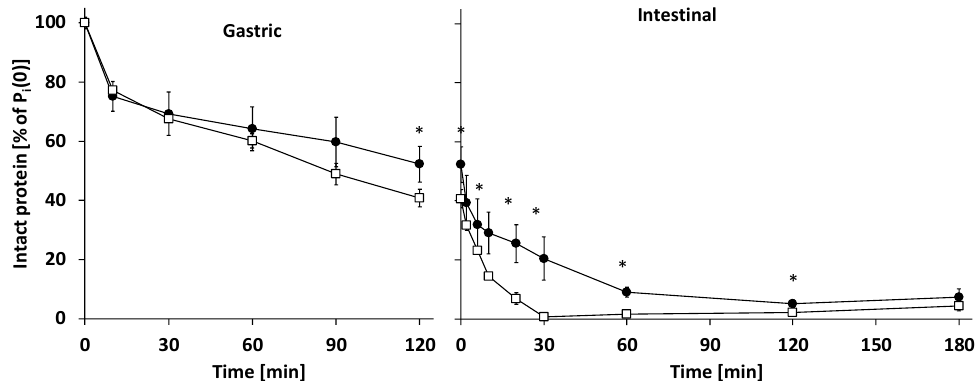
Figure 5. Total intact protein hydrolysis in gastric and intestinal digesta in time, as determined by SDS-PAGE and densiometric analysis of bands. ( • ) Human milk (HM), ( ) infant formula (IF); total intact protein expressed as % of total intact milk protein amount at t = 0 (P i (0)). Mean ± SEM (n = 3). * Significant difference ( p <0.05).